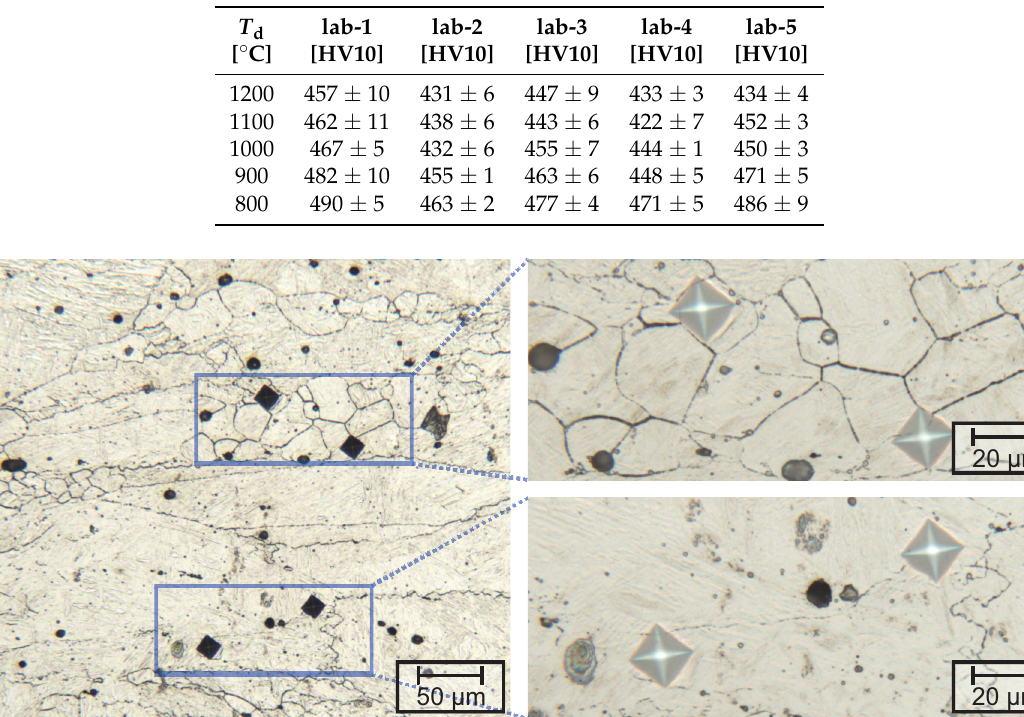
Figure 7. Micrographs of micro hardness indentations (HV0.1) in alloy lab-4 deformed at 1000 ◦